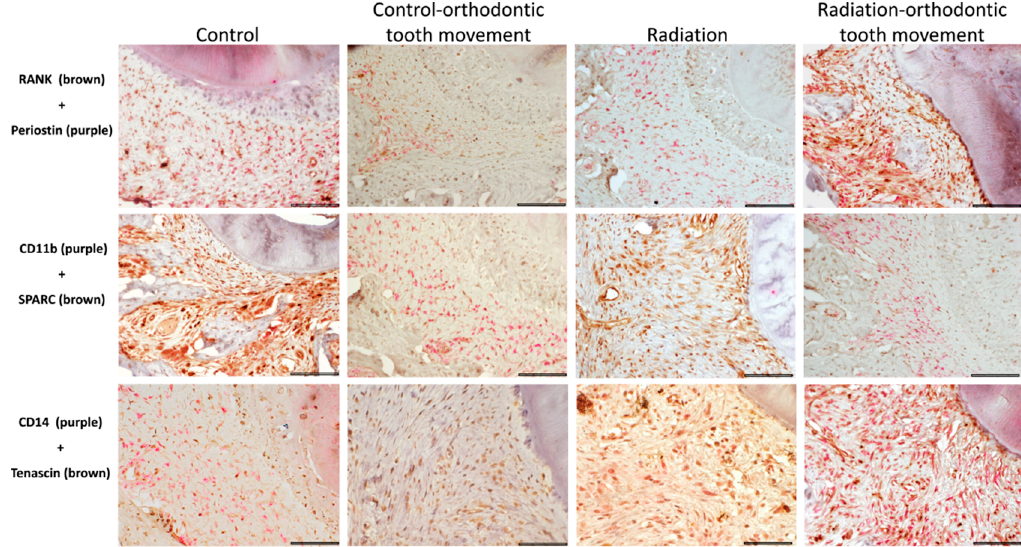
Figure 5. Changes in cells immuno-positive for pre-osteoclast markers (RANK, CD11b, CD14) and pre-osteoblast cells (SPARC, periostin, tenascin) as a factor of orthodontic force and radiation.